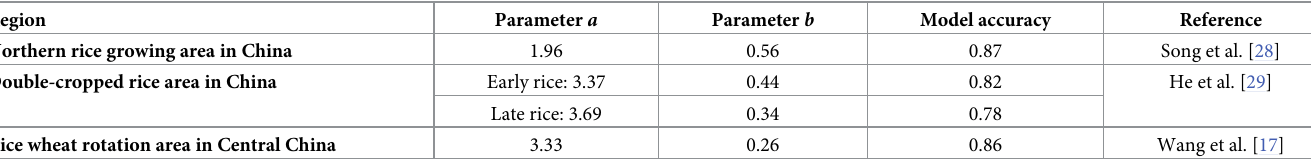
Table 4. The model comparison